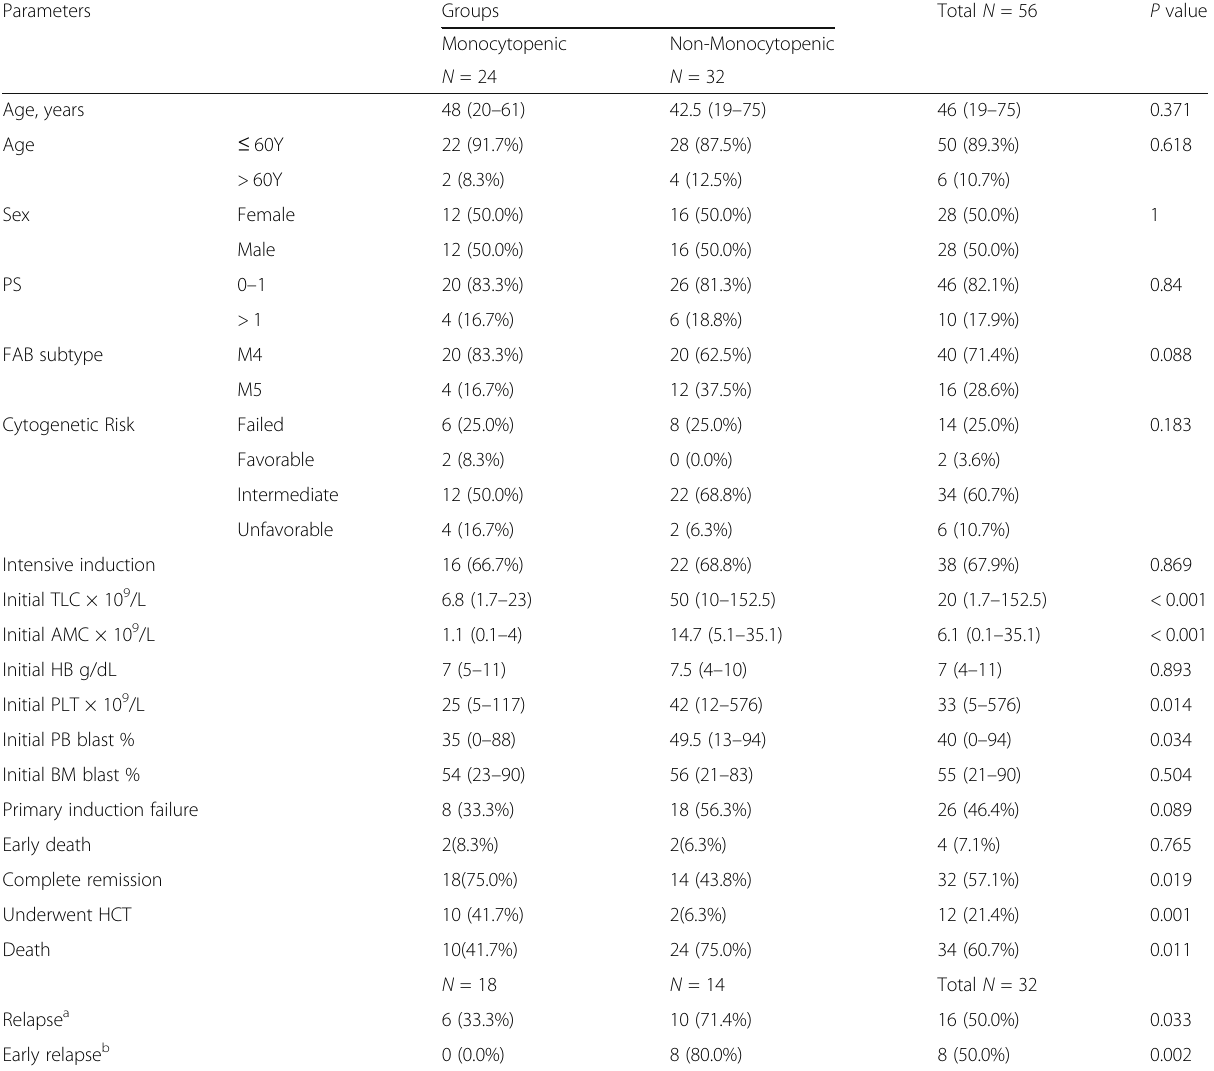
Table 1 Patients ’ clinical characteristics and outcome [median (range) or n (%)] in both groups